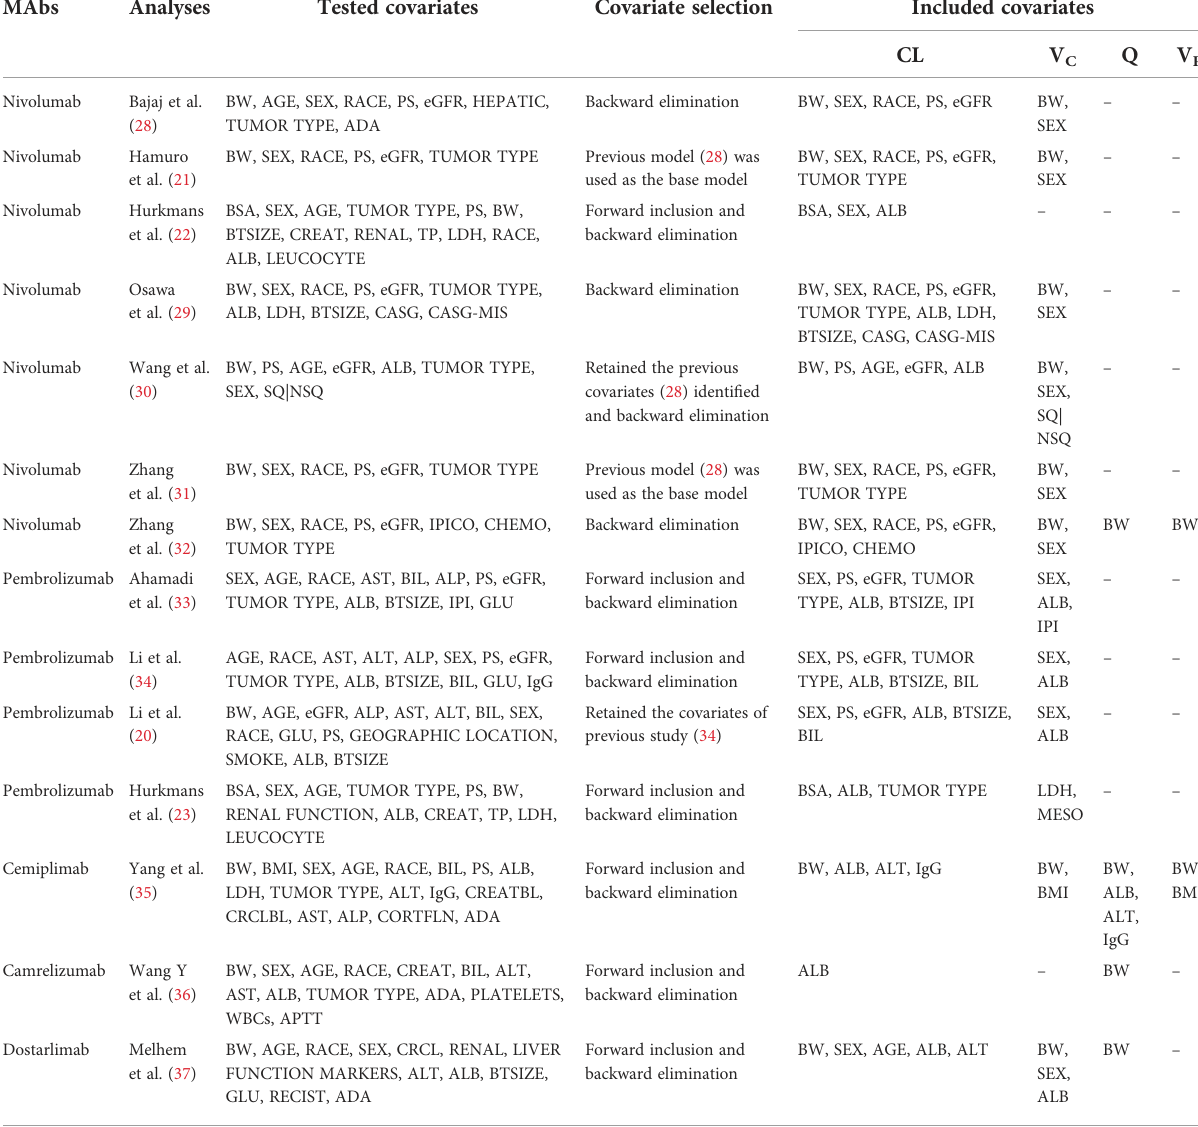
TABLE 4 List of tested and included covariates in the PPK models of anti-PD-1 mAbs.